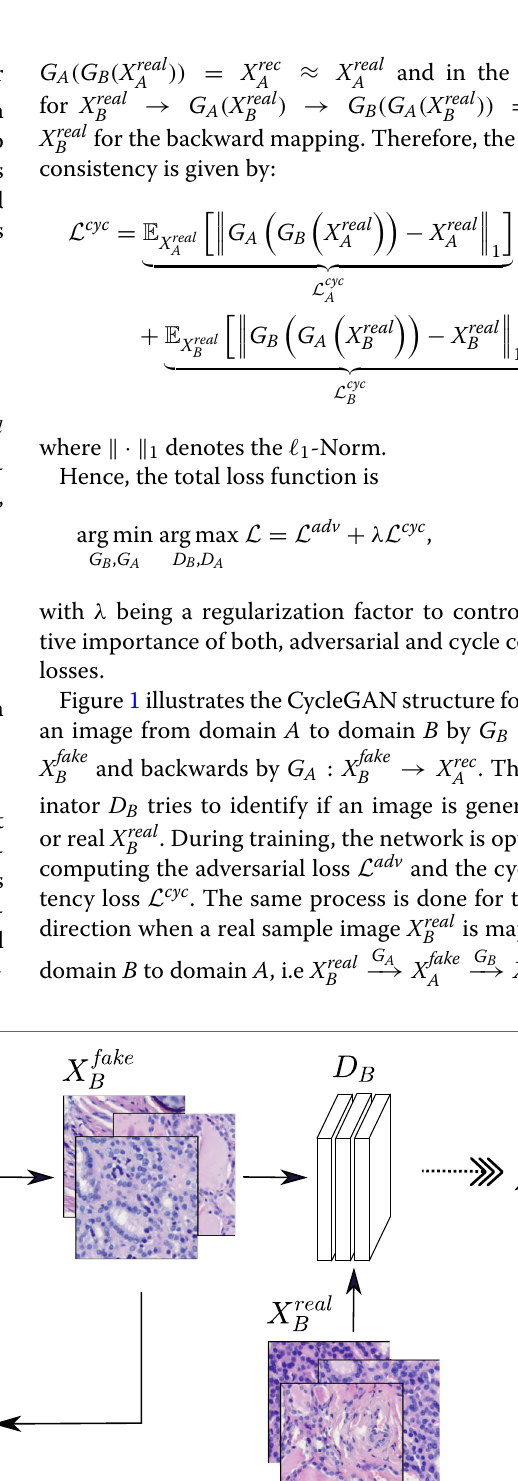
→ X fake and then back to domain A by the generator G A : X fake A B